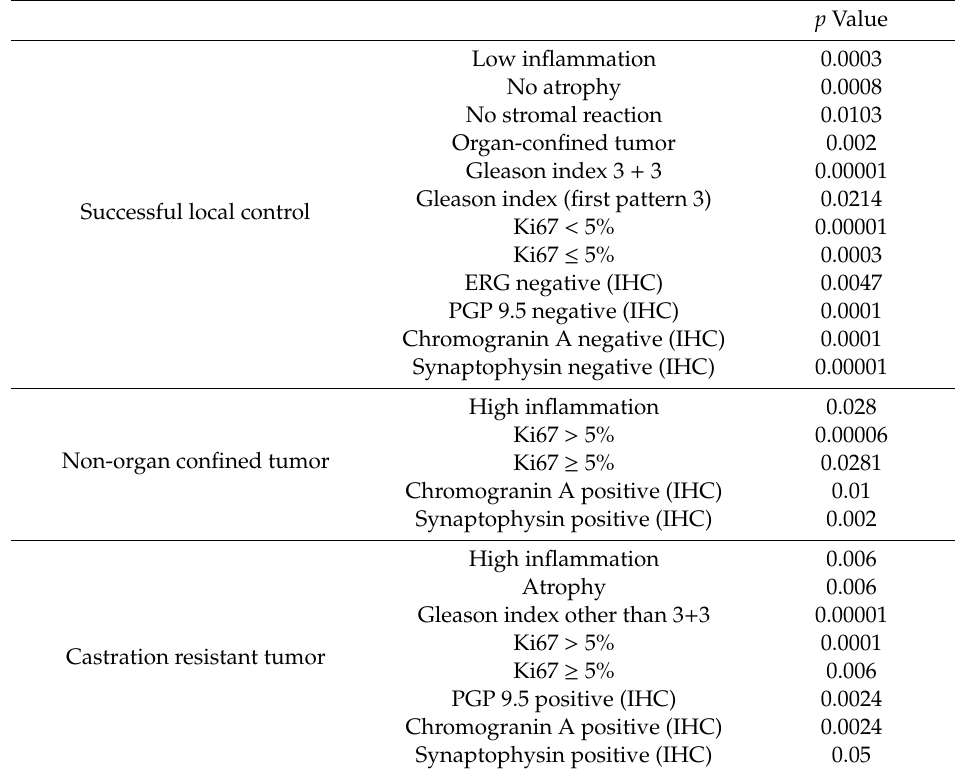
Table 3. Dependent parameters for successful local control, non-organ confined staging, and castration resistance status in 27 oligometastatic prostate adenocarcinomas (Fisher exact